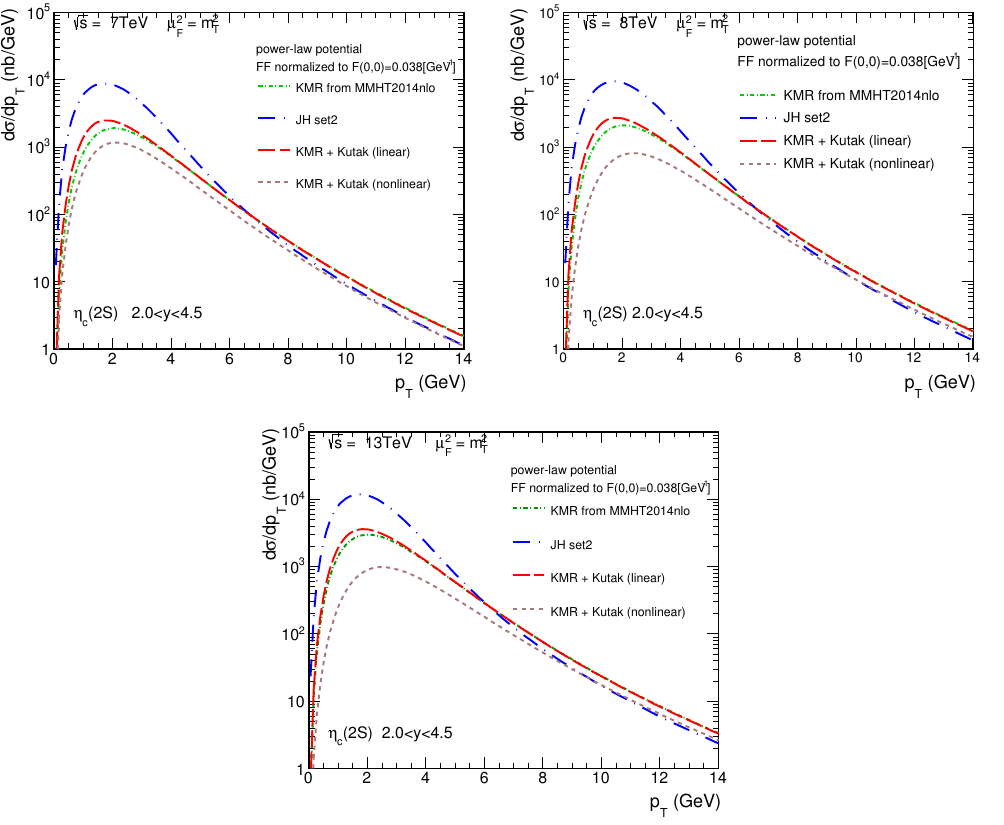
Figure 8 . Di(cid:11)erential cross section as a function of transverse momentum for prompt (cid:17) c (2 S ) p production for s = 7 ; 8 ; 13